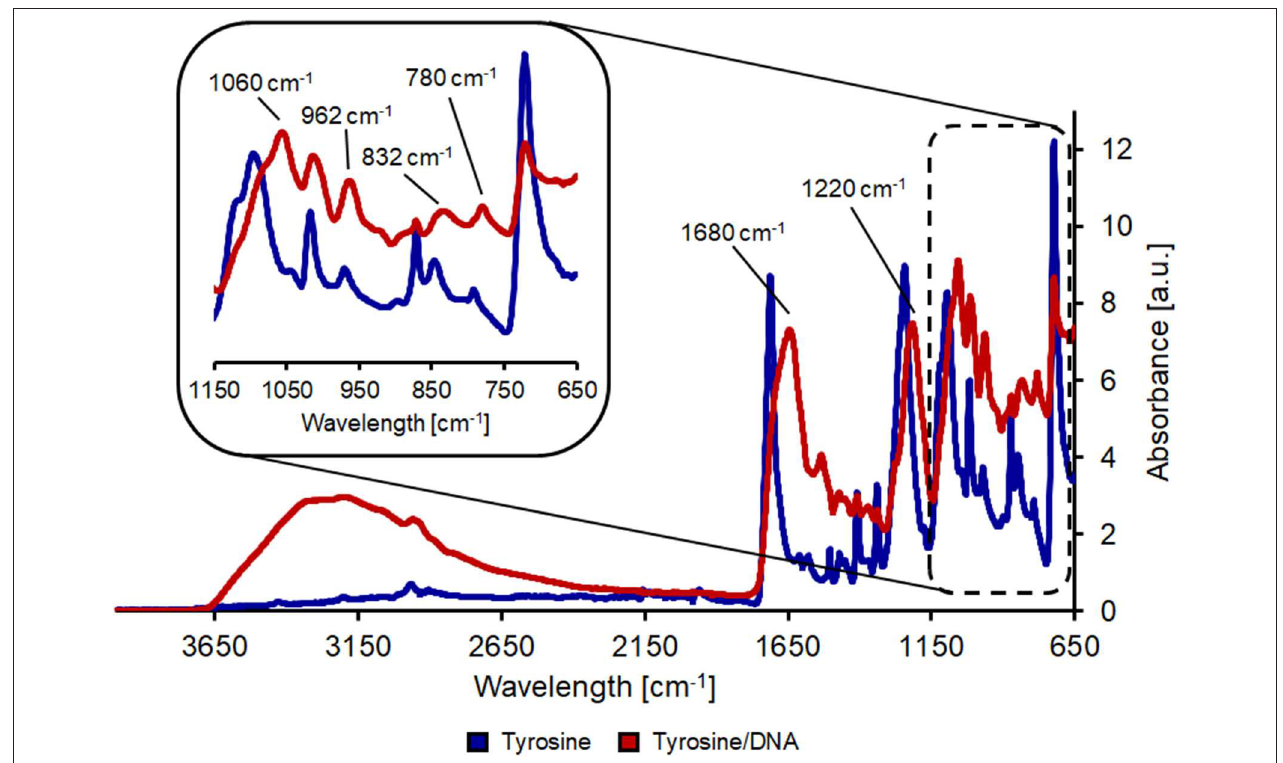
FIGURE 3 | FT-IR analysis of hydrolyzed PET after coating with tyrosine (blue line) and after tyrosine/DNA coupling (red